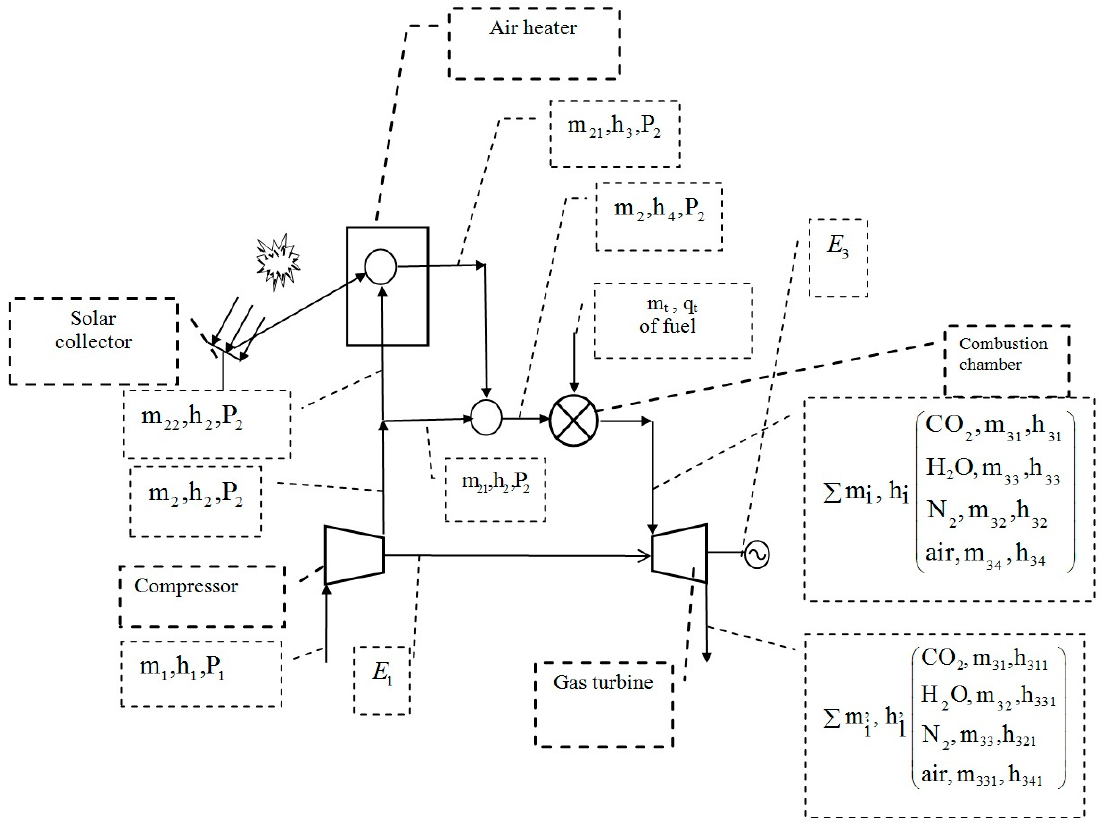
Figure 4. Schematic diagram of a hybrid mini thermal power plant with a solar air heater [36].